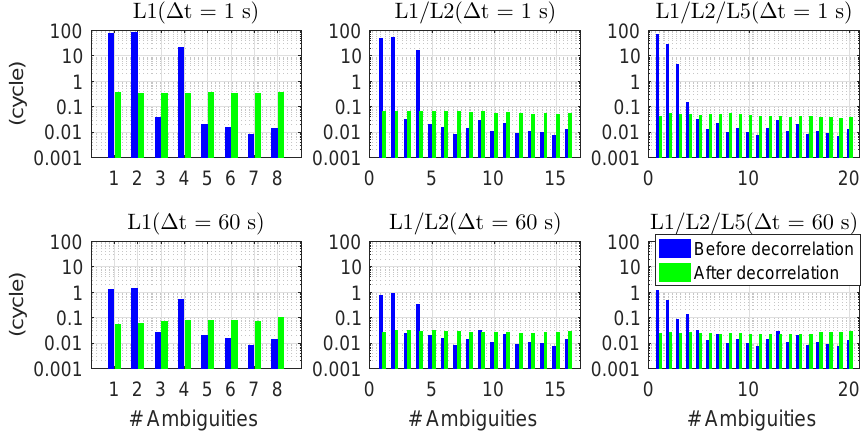
before the decorrelation and i | I